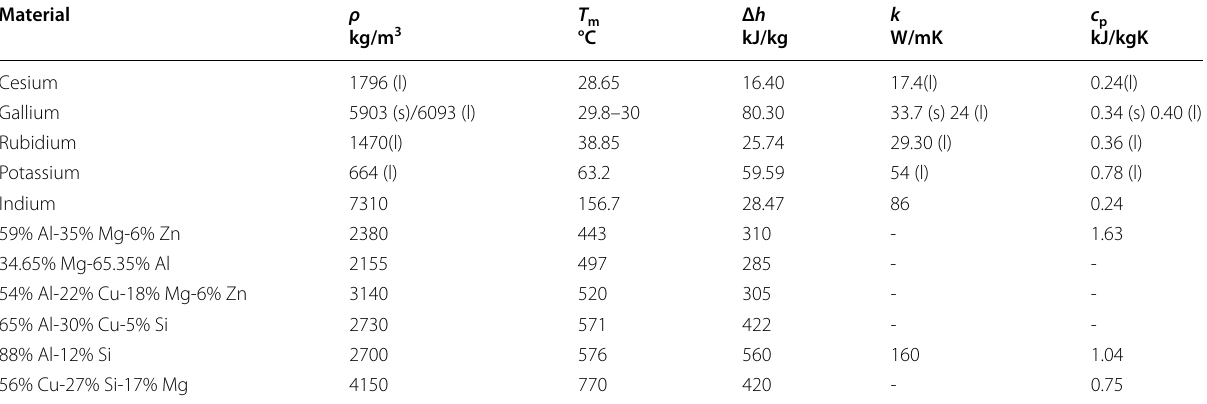
Table 4 Thermophysical properties of selected metals and metal alloys as PCMs [66, 73] Material